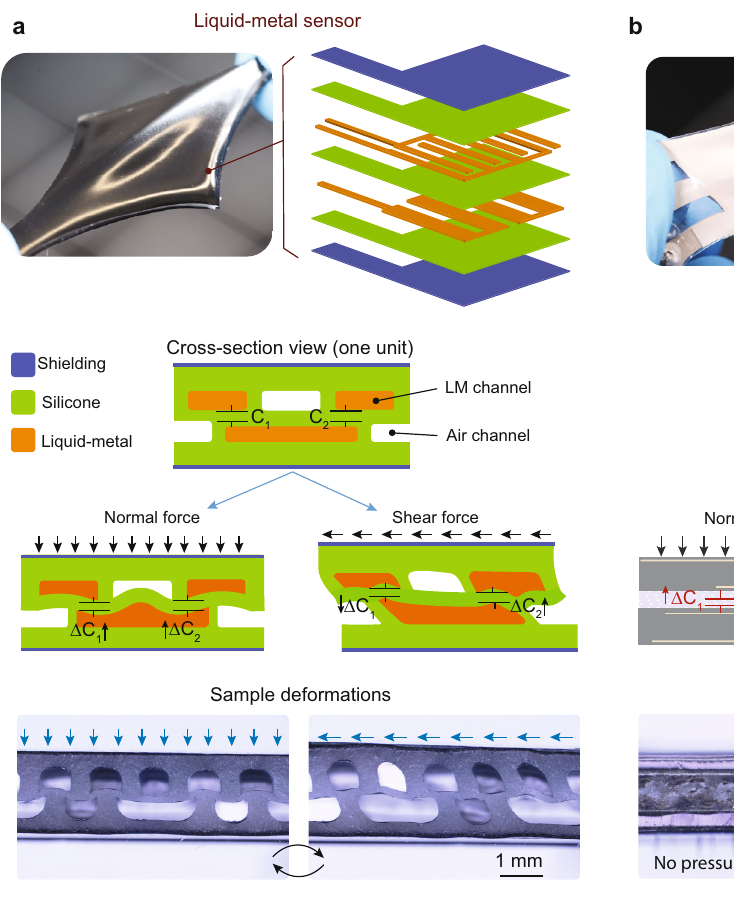
Fig. 2 | Working principle of the shielded soft sensors. a Exploded view of the liquidmetal(LM) fi lledmicrochanneldesign.Themulti-axissensingisbasedonthe relative capacitance change of two capacitors sharing a common excitation elec- trode. The cross-section views of a sensing unit demonstrate the change of these capacitances when loaded with normal or shearforces. The micrographs showthe deformation of the micro-channels when pressed or sheared. b Exploded view of